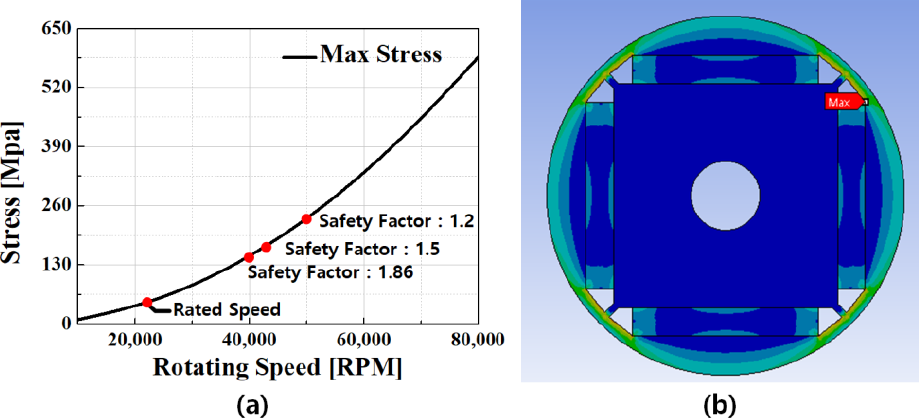
Figure 8. Stress analysis result according to rotating speed and distribution. ( a ) Max stress plot. ( b ) Stress distribution at the rotor core.